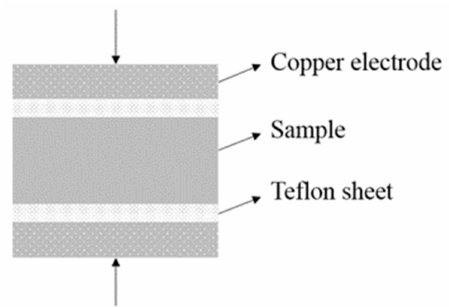
Figure 5. Test model of the samples for dielectric behaviors and electrical